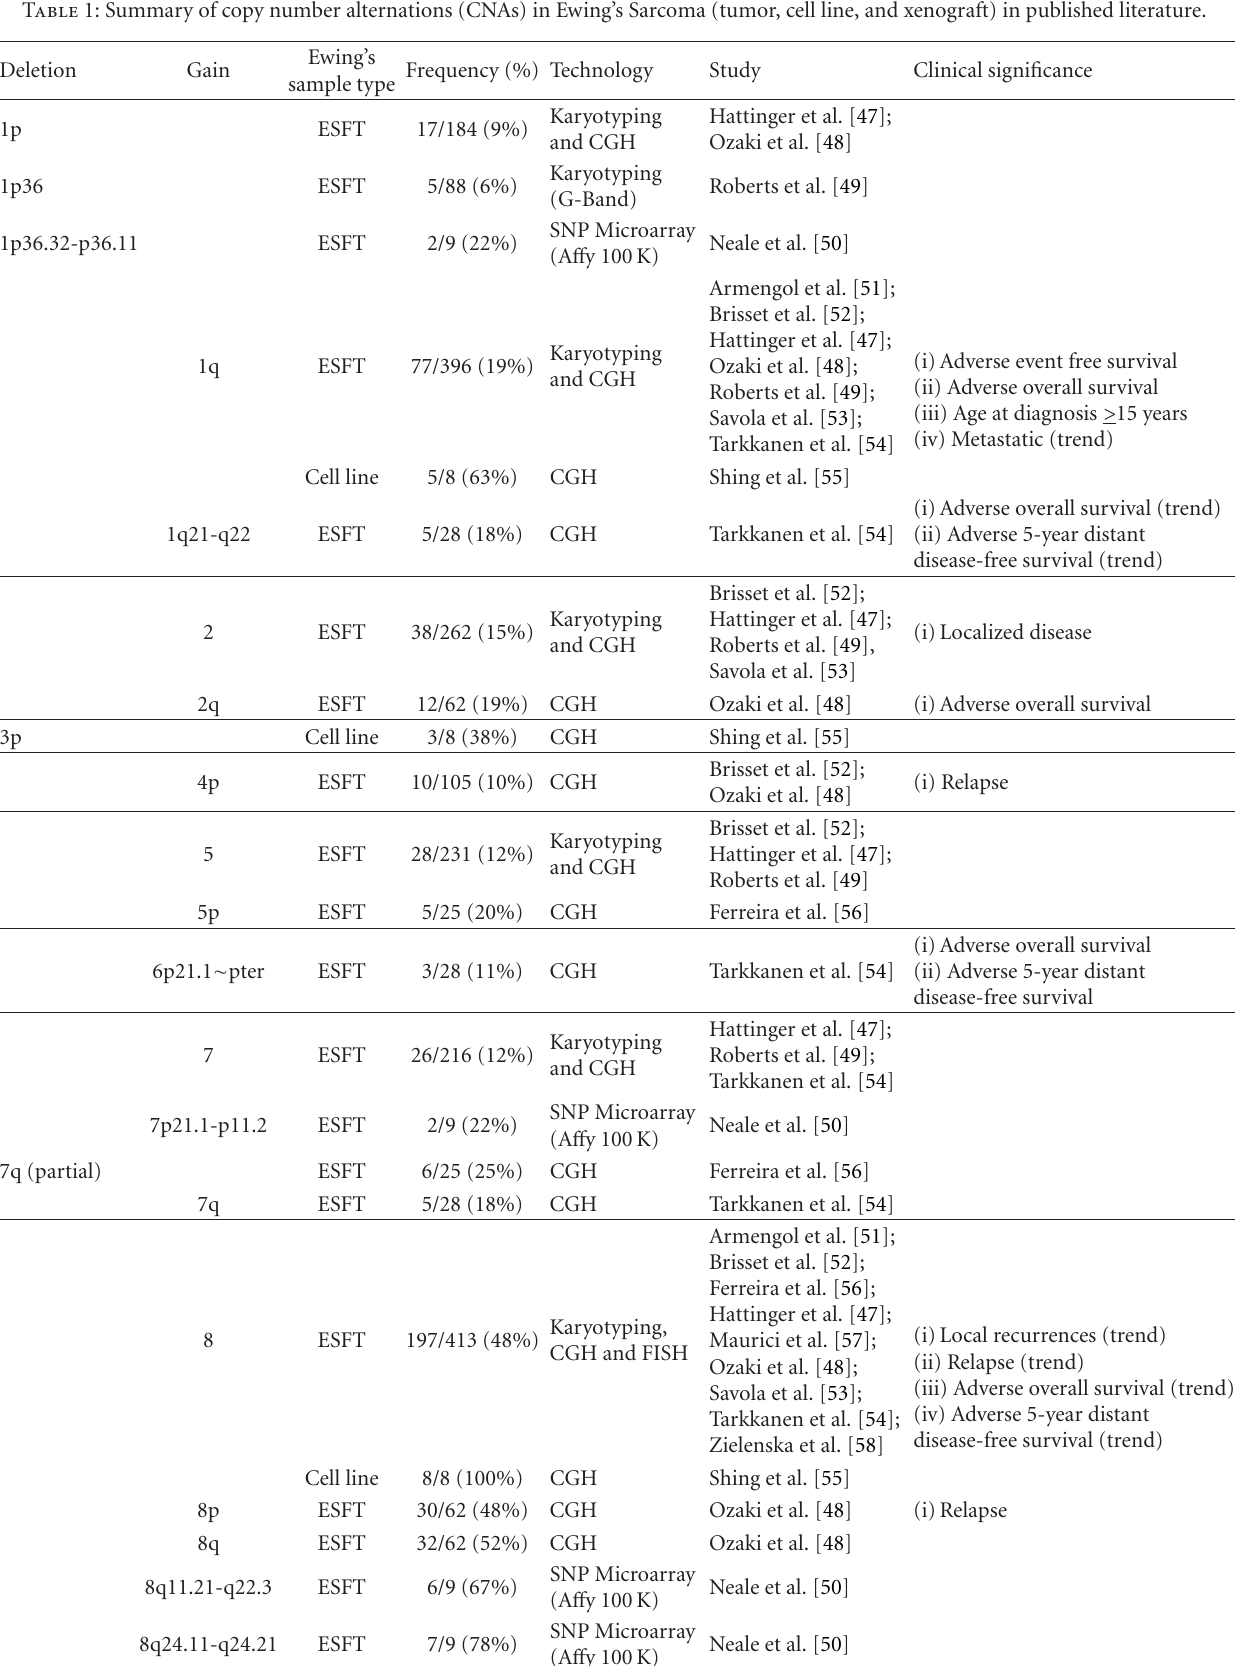
Table 1: Summary of copy number alternations (CNAs) in Ewing’s Sarcoma (tumor, cell line, and xenograft) in published literature.